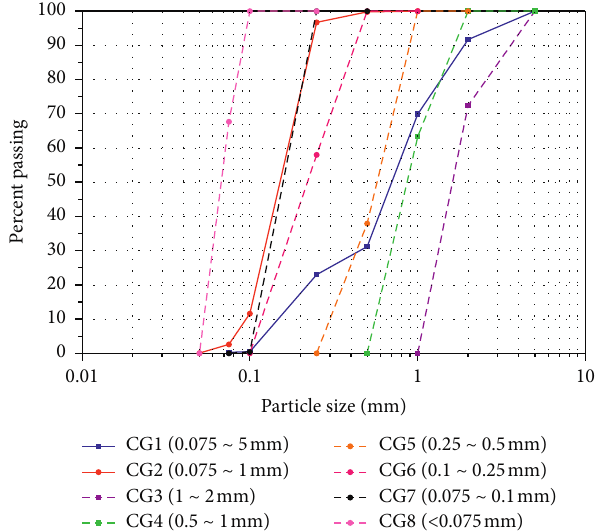
Figure 1: Grain composition curve of different control